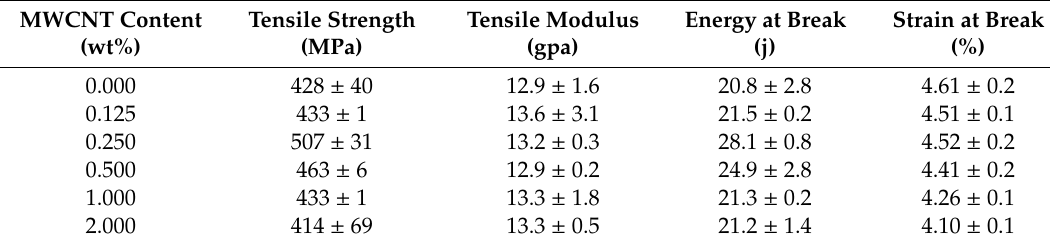
Table 3. Tensile properties of nanocomposite laminates with 8 plies aramid / poly(BA-a-co-PU) and different wt% of multi-walled carbon nanotubes (MWCNTs).